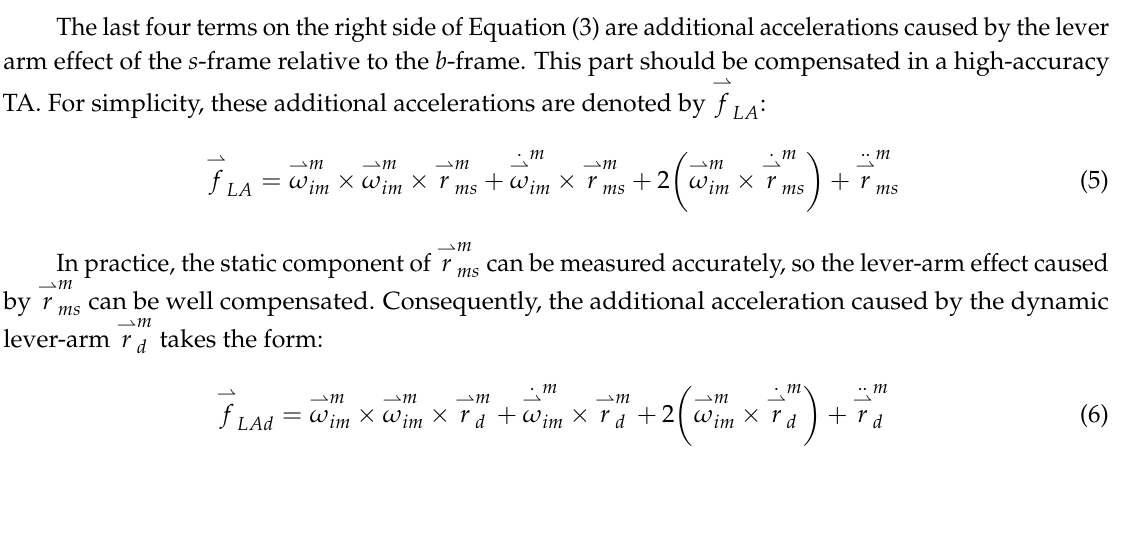
Figure 1. Schematic diagram of the measurement of misalignment Figure 1 . Schematic diagram of the measurement of misalignment angle.